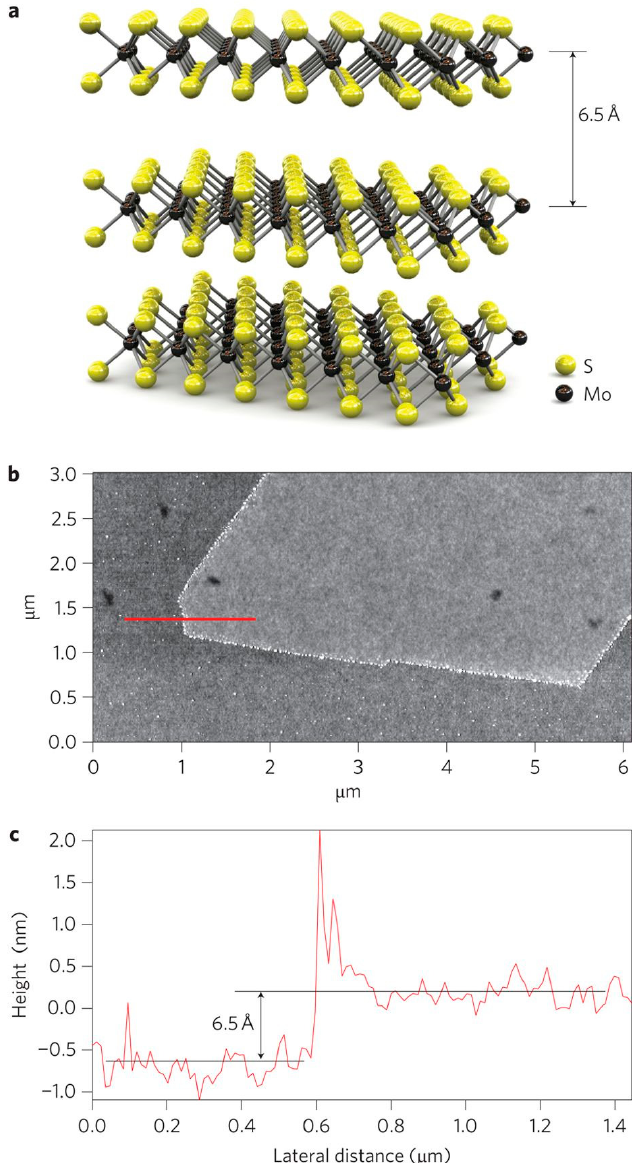
Figure 11. ( a ) 3D schematic illustration of the structure of MoS 2 , implying each single layer is 6.5 Å thick. Individual layers can be separated by scotch tape and via micromechanical cleavage. ( b ) AFM micrograph of a single MoS 2 layer, overlaying a silicon substrate. ( c ) The cross-sectional plot monitored on the red line shown in b. Reproduced with permission [162]. Copyright 2011, Springer Nature.